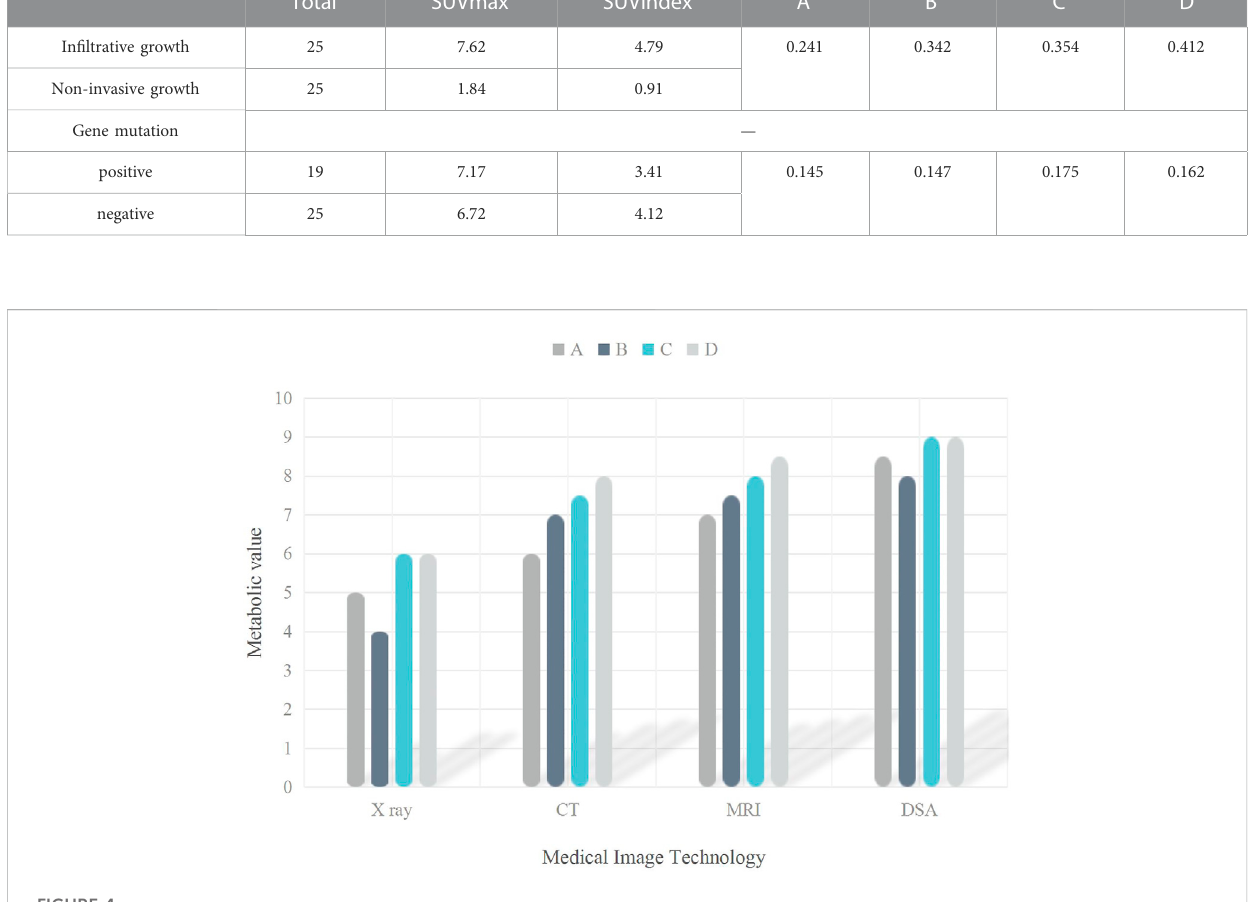
FIGURE 4 Medical image of the gene mutation in the lung adenocarcinoma in the driver